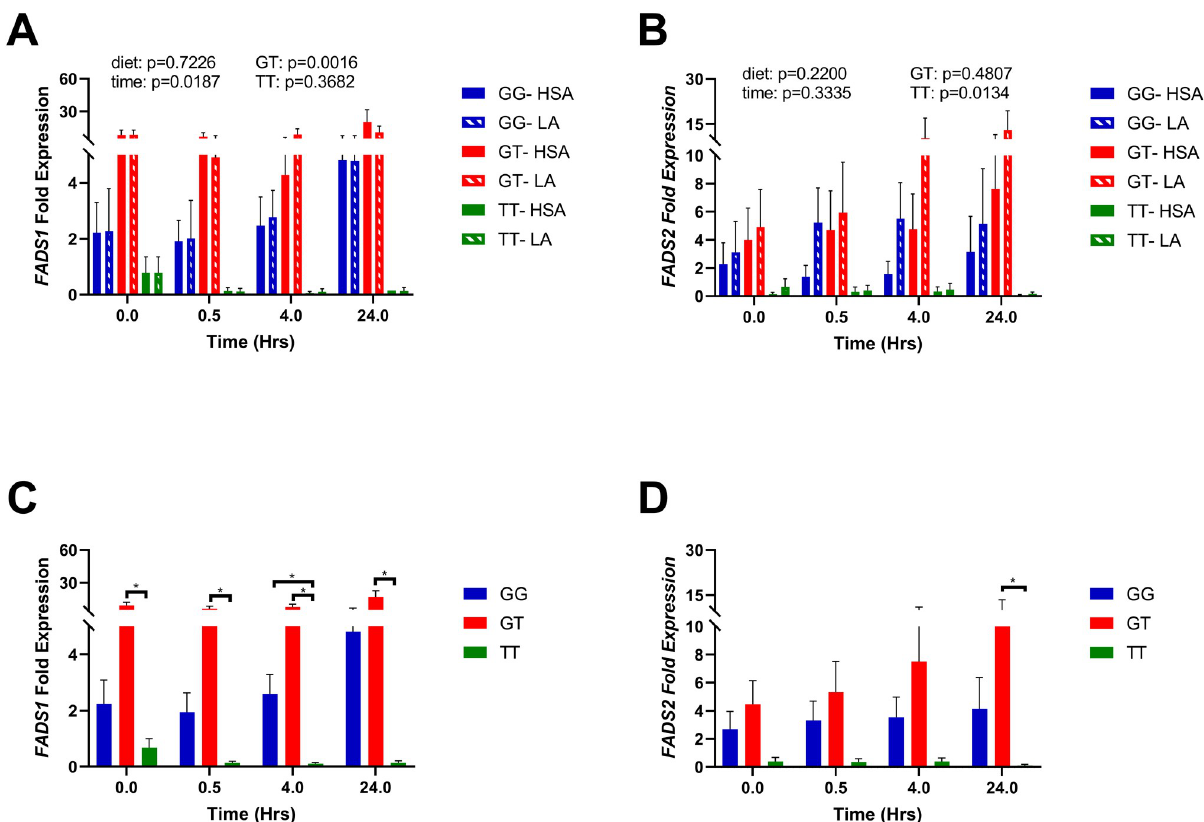
Fig 7. Expression of FADS1 and FADS2 is associated with genotype at rs174537 . Effect of diet and genotype at rs174537 were analyzed using a linear regression model, where GG at rs174537 was considered the referent genotype. Data are reported as mean with SEM. No significant differences were observed in the expression of (A) FADS1 or (B) FADS2 between LA-exposed and human serum albumin (HSA)-control hepatic culture models. When analyzed by genotype alone, (C) FADS1 expression was significantly higher in GT constructs, and lowest in TT constructs. (D) A similar trend was seen in FADS2 expression. Interestingly FADS1 and FADS2 expression levels were highest in GT donors.